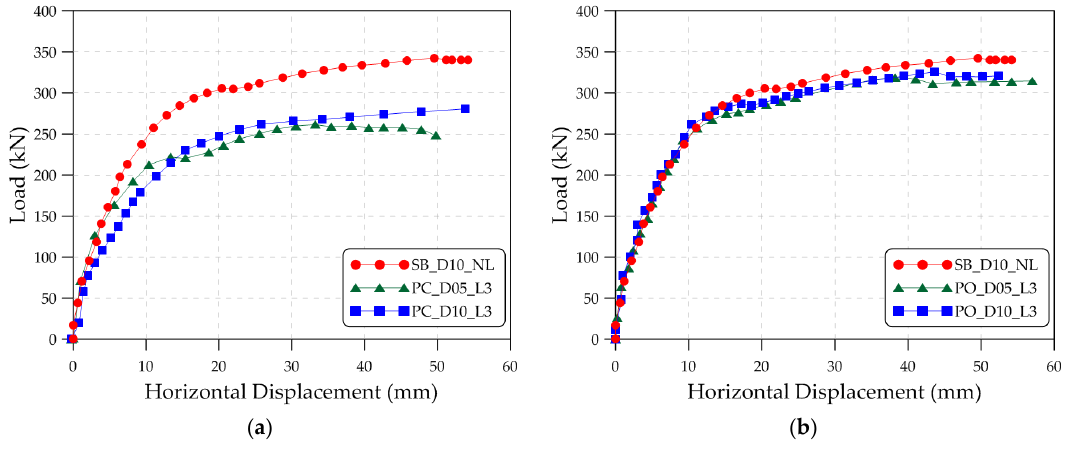
Figure 10. Effect of infilled concrete depths. ( a ) PC_L3 specimens. ( b ) PO_L3 specimens. Table 6. Effect of infilled concrete depths for PC_L3 specimens. Table 6. Effect of infilled concrete depths for PC_L3